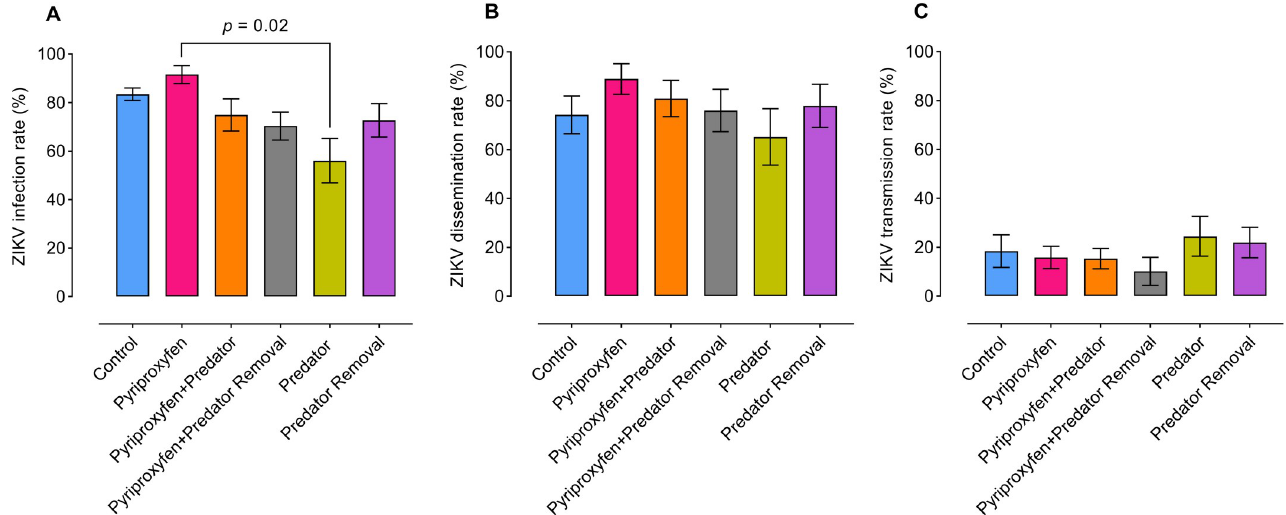
Fig 4. Effects of juvenile treatments on Ae. aegypti -ZIKV interactions. (A) Zika virus infection, (B) disseminated infection, and (C) saliva infection (transmission) were determined following orally exposure to ZIKV infectious blood meals. Bars represent the means. Whiskers denote the standard error of the means. For all treatments, viral infection, disseminated infection, and transmission were estimated at 15 days post-ZIKV infection. Control ( n = 80), pyriproxyfen ( n = 50), pyriproxyfen+predator ( n = 47), pyriproxyfen+predator removal ( n = 64), predator ( n = 49), and predator removal ( n = 63). Statistical significance was determined by